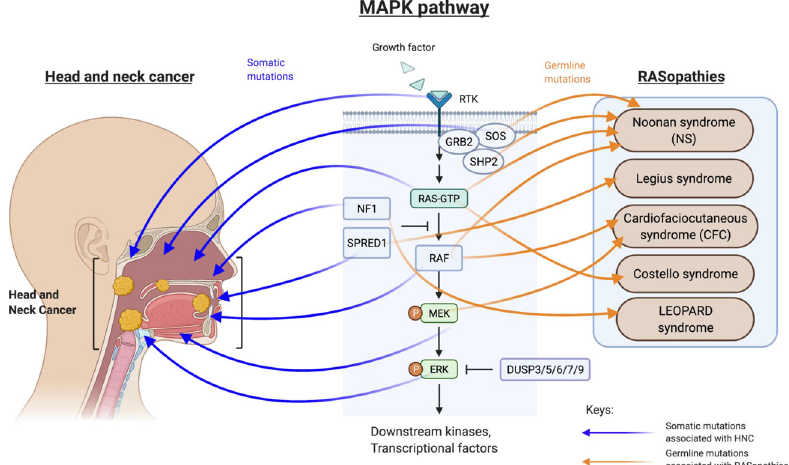
Fig. 2 Components of the MAPK pathway are mutated in both HNSCC (at somatic level) and in various RASopathies at germline level. These RASopathies display head and neck deformities include the Noonan syndrome, Legius syndrome, cardiofaciocutaneous syndrome, and Costello